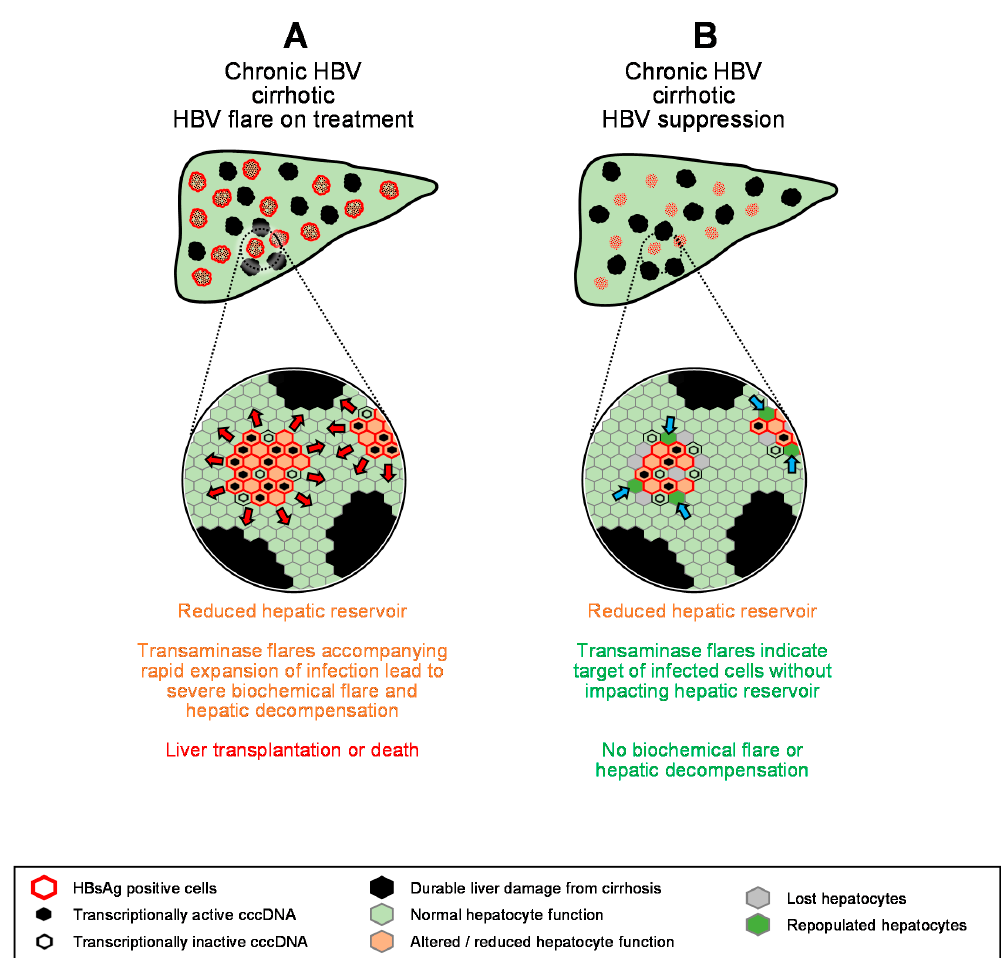
Figure 5. Model for the impact of transaminase flares on the hepatic reservoir in cirrhotic patients ( A , B ). Red arrows indicate expansion of HBV infection, blue arrows indicate regeneration of normal hepatocytes.